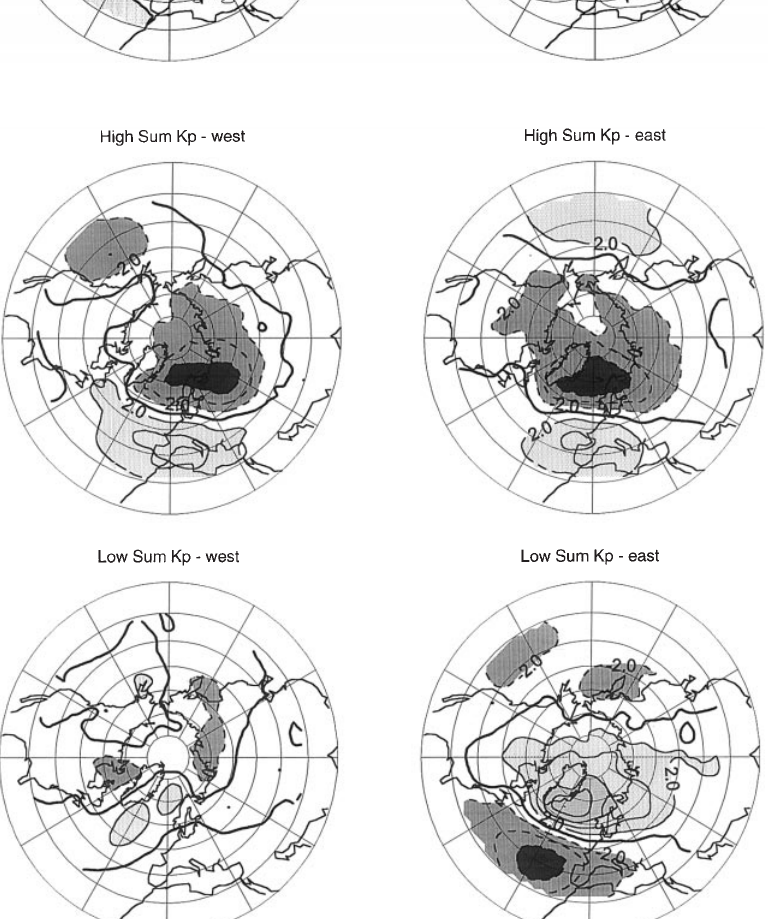
Fig. 1. Winter period dominant barometric sys- tems over the Northern Hemisphere. The Siberian anticyclone remains almost independent of the level of geomagnetic activity and QBO-phase. The deepening of the Icelandic and Aleutian low alternate with high and low Kp values and QBO- east phase. The intervals between contours are 5 mb